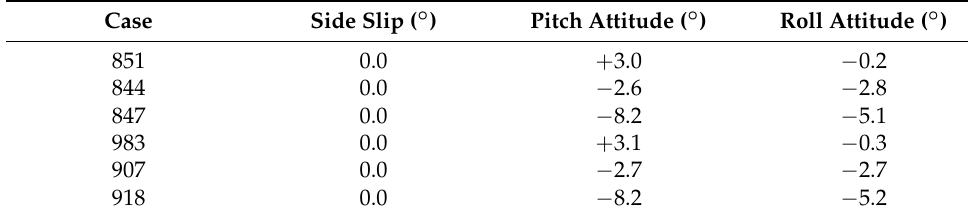
Table A3. BO105 Helicopter attitudes.